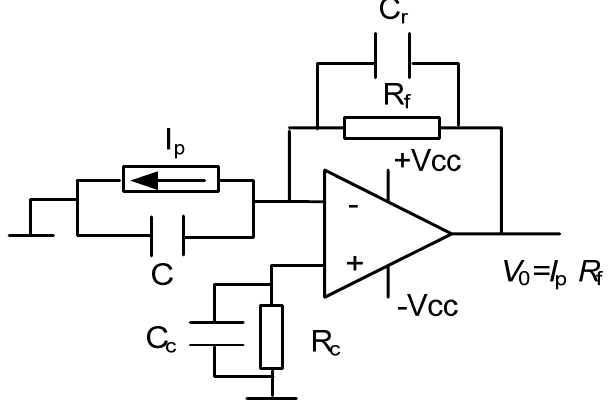
signal provided by the p